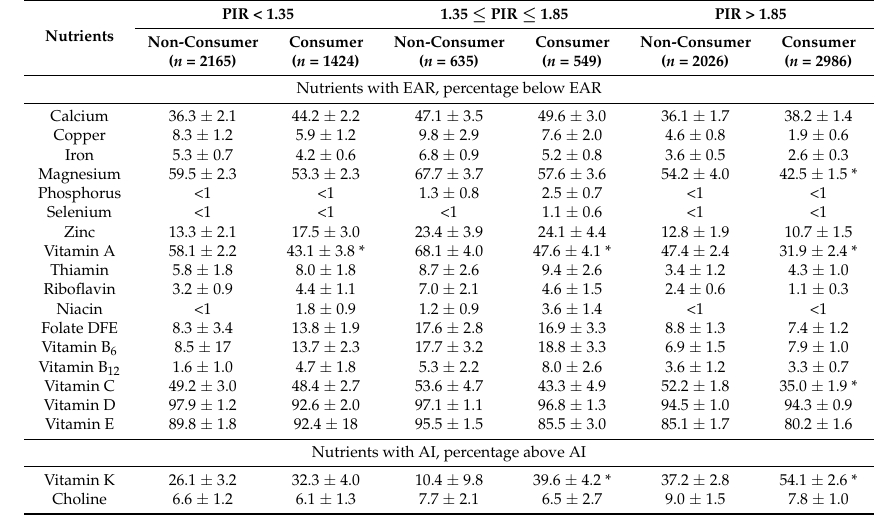
Table 2. Percent of adult (19+ years old) population below Estimated Average Requirement (EAR) or above Adequate Intake (AI) of nutrients from foods only by PIR subgroups. NHANES 2009–2012 gender combined data.